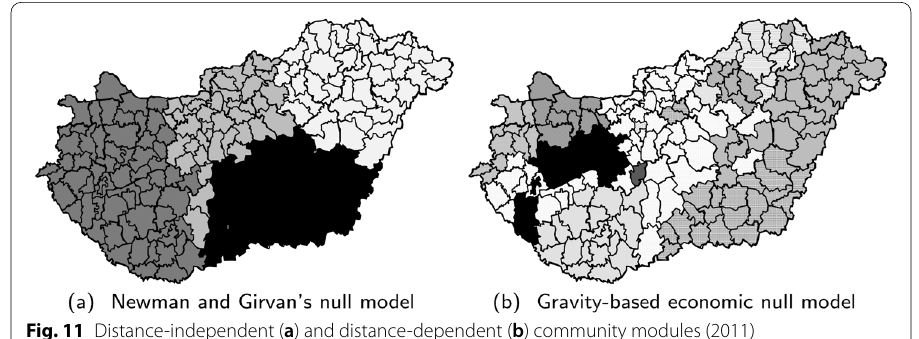
Fig. 11 Distance‑independent ( a ) and distance‑dependent ( b ) community modules (2011)